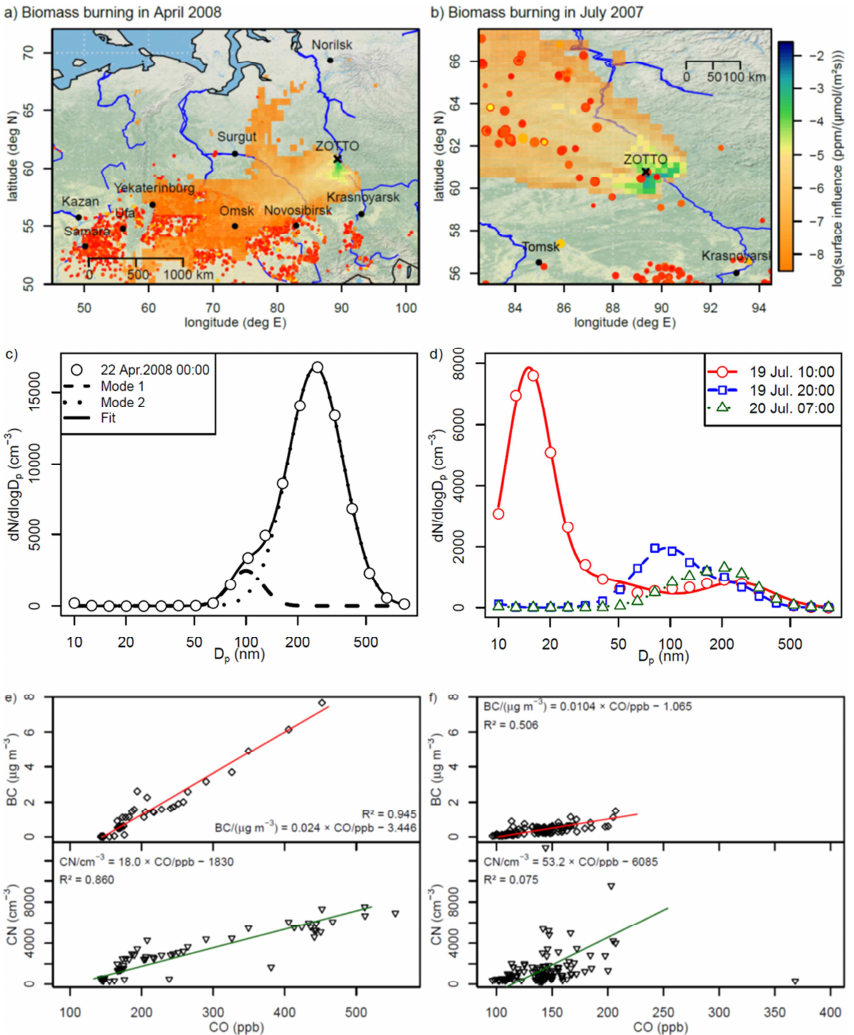
Figure 8 Footprint overlaid with a fire map, aerosol size distribution, and ∆ BC e / ∆ CO and ∆ CN/ ∆ CO scatter plots for biomass burning events in April 2008 and July 2007. Fig. 8. Footprint overlaid with a fire map, aerosol size distribution, and BC e vs. CO and CN vs. CO scatter plots for biomass-burning events in April 2008 and July